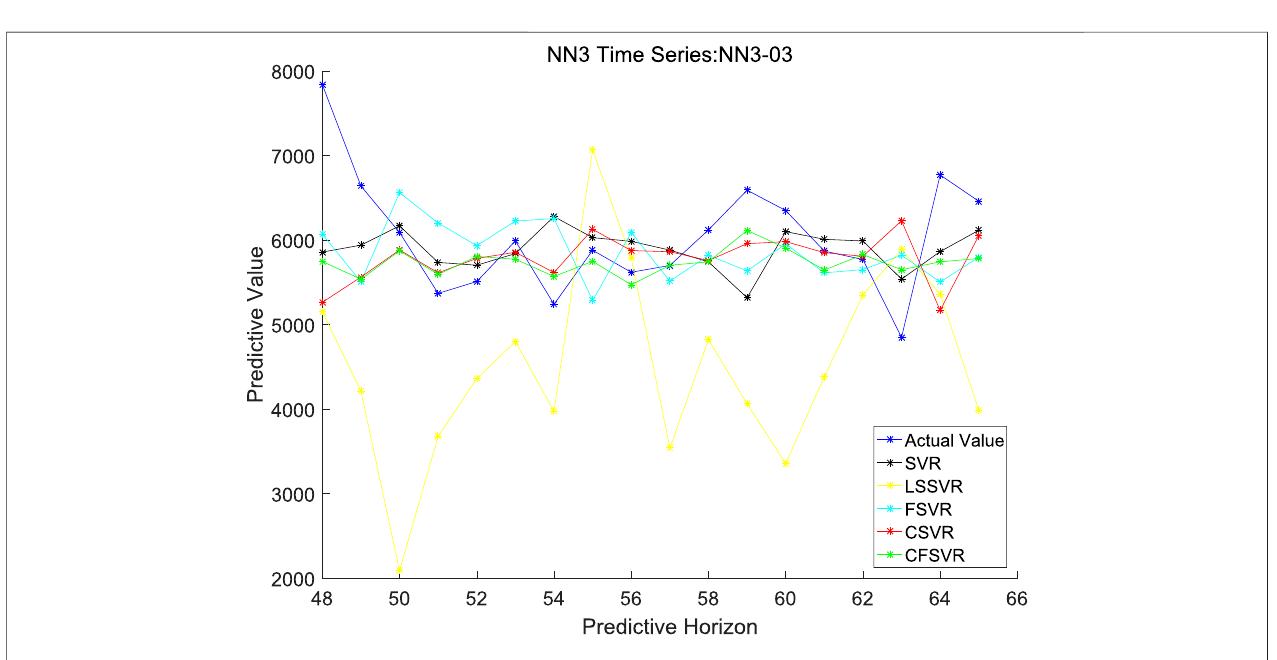
FIGURE 11 | Forecasting of NN3 No.